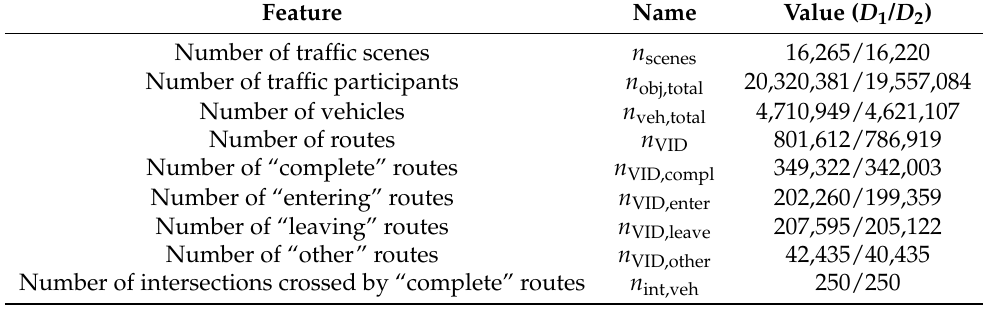
Table 2. Summary of the details of the VIDs generated from D 1 and D 2 .